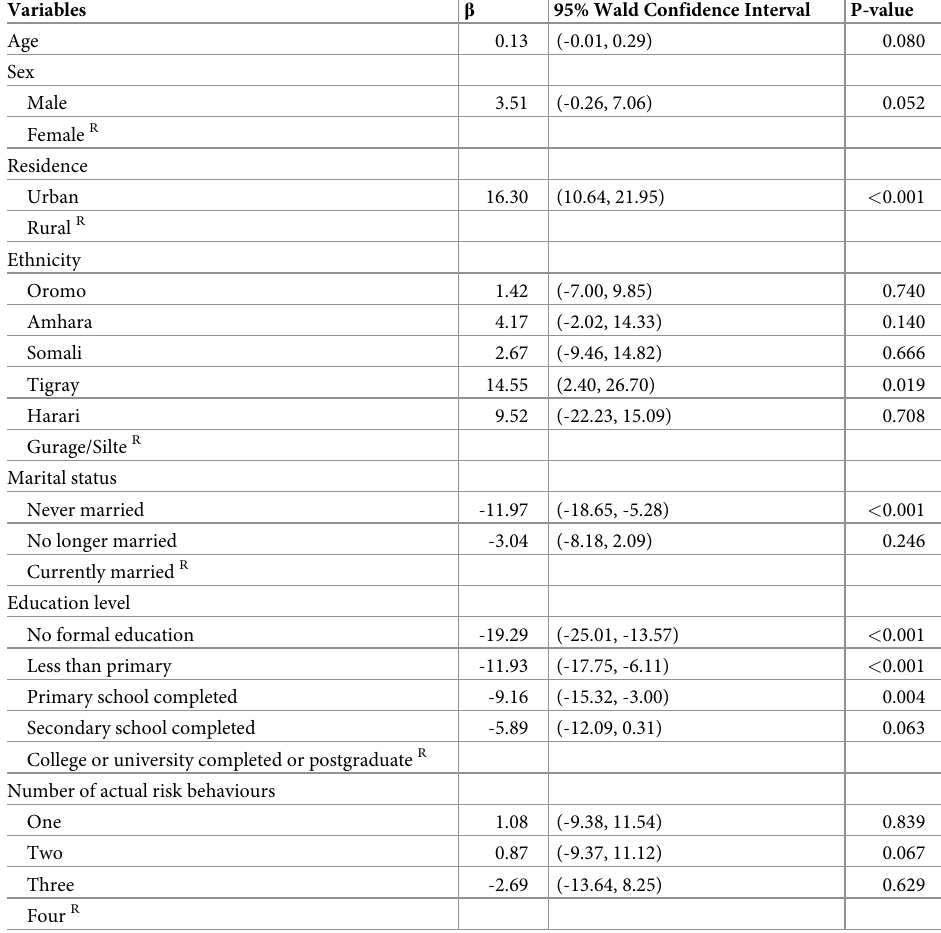
Table 3. Bivariate linear regression analysis of associated factors of knowledge of CV risk factors in eastern Ethio- pia,